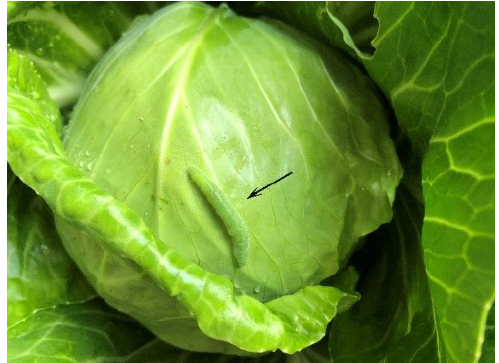
Figure 1. Field pests with protective color characteristics.